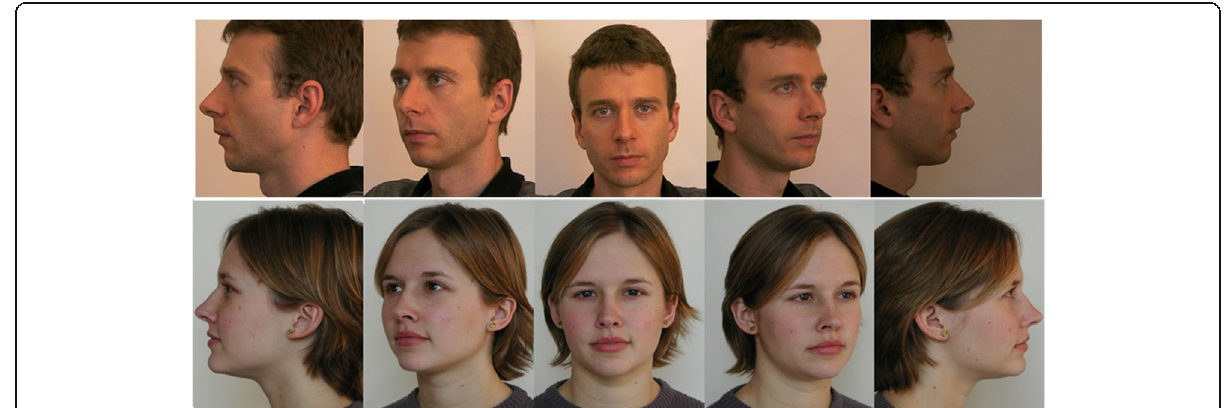
Fig. 7 Pose change face image of MIT-CBCL database